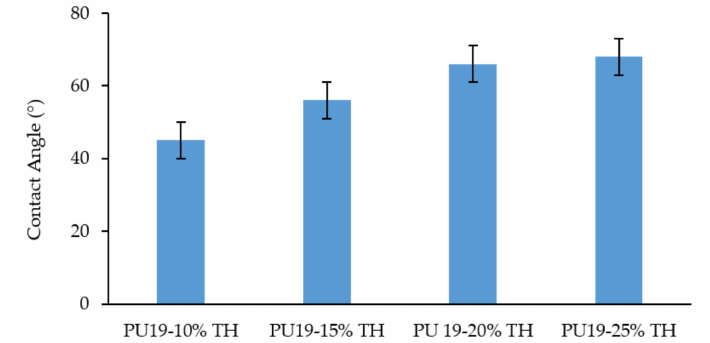
Figure 2. Water contact angle of PU terbinafine nail lacquers, nail as control, (mean ± SD, n = 6).